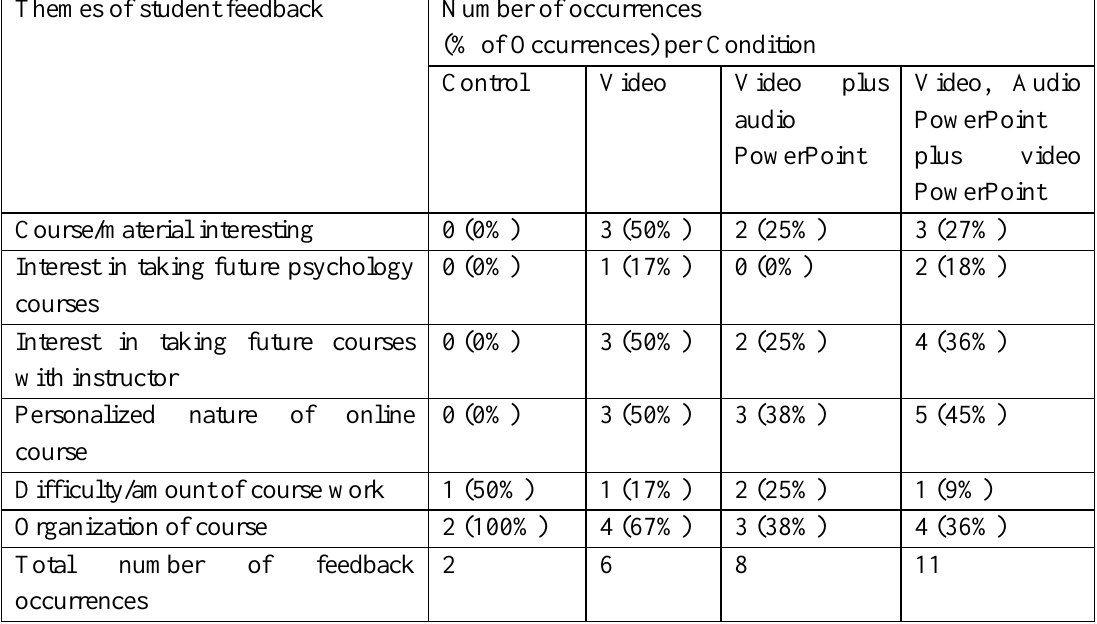
Table 5 Theme of Student Feedback by Multimedia Condition Themes of student feedback Number of occurrences